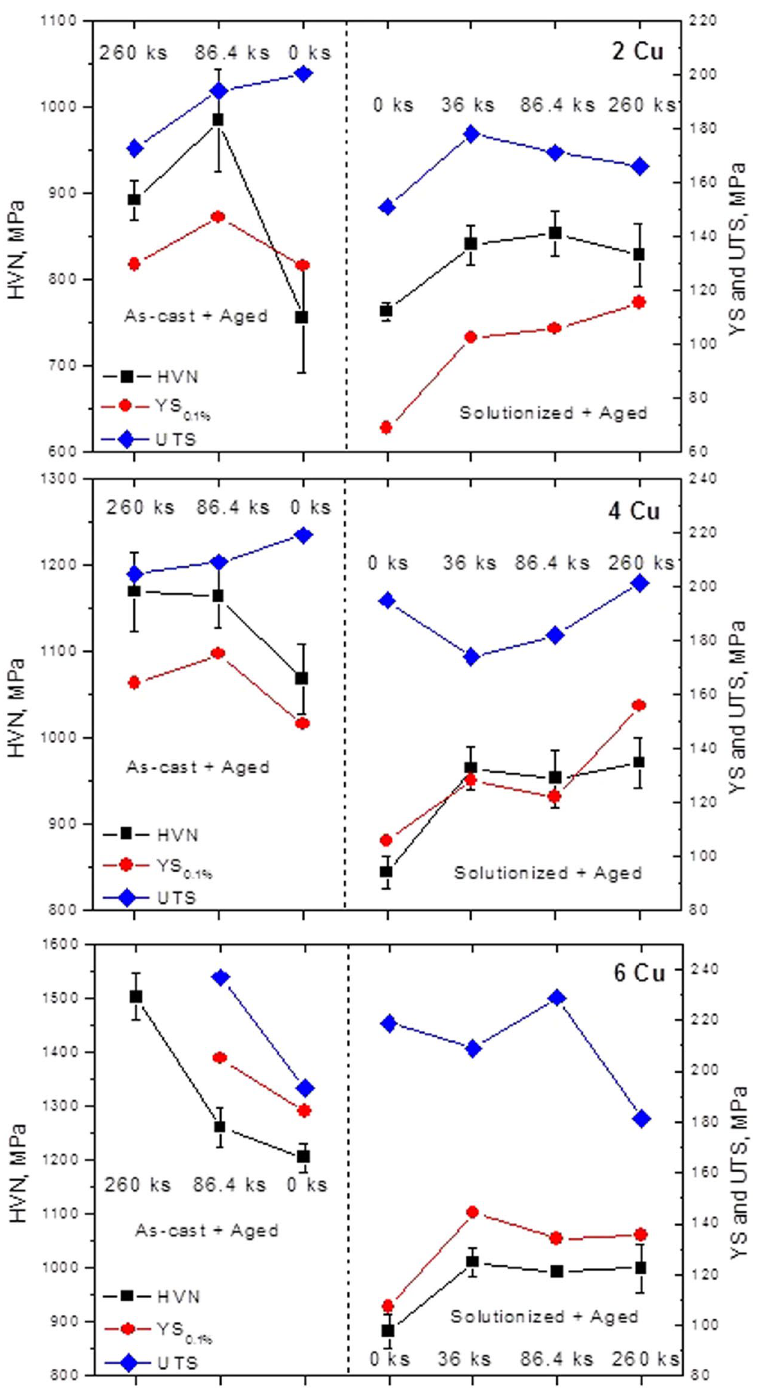
Figure 6. Combined plots for Vickers micro-hardness (HVN), 0.1% offset yield stress (YS) and UTS of 2Cu, 4Cu and 6Cu samples after ageing at 473 K for different durations in as-cast condition (left side of the dashed line) and after solutionization at 793 K for 43.2 ks (right side of the dashed line). Lines connecting the data points are only for the visual